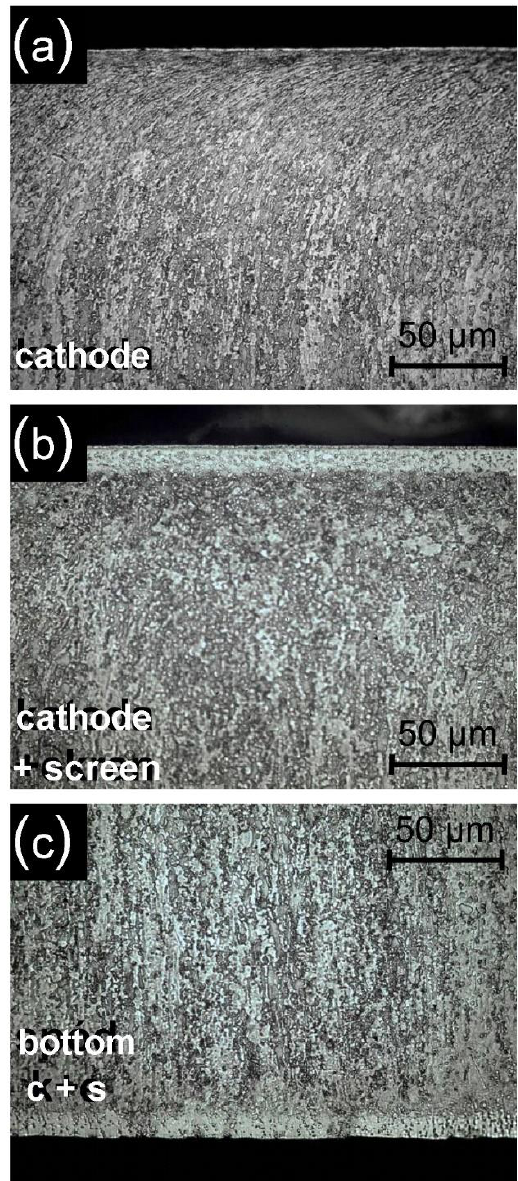
Figure 10. The microstructure of the nitrided layer on the substrate of Grade 5 titanium different variants of the samples’ distribution in the glow chamber: ( a ) cathode, ( b ) cathode + screen, alloy for different variants of the samples ’ distribution in the glow chamber: ( a ) cathode, ( c ) cathode + screen (with sample bottom). Process temperature T = 530 ◦ C, time t = 17 ( b ) cathode + screen, ( c ) cathode + screen (with sample bottom). Process temperature T = 530 °C, time t = 17 h.